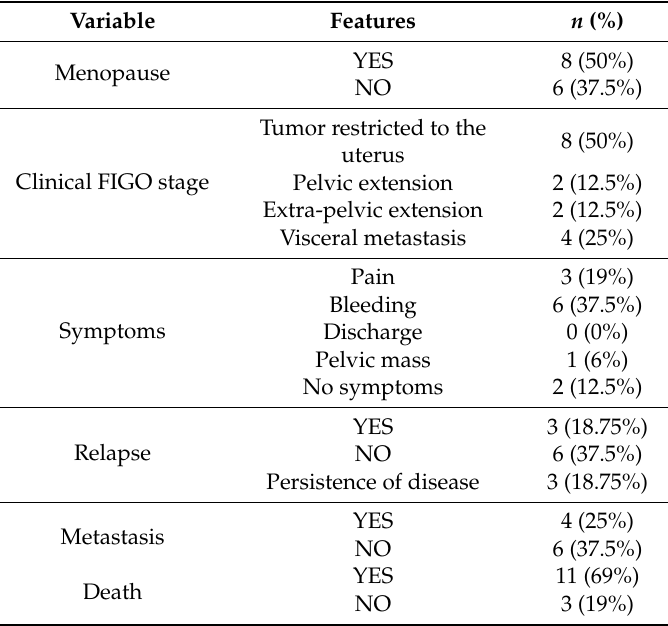
Table 1. Patients profile with ULMS ( n = 16) *. Variable Features